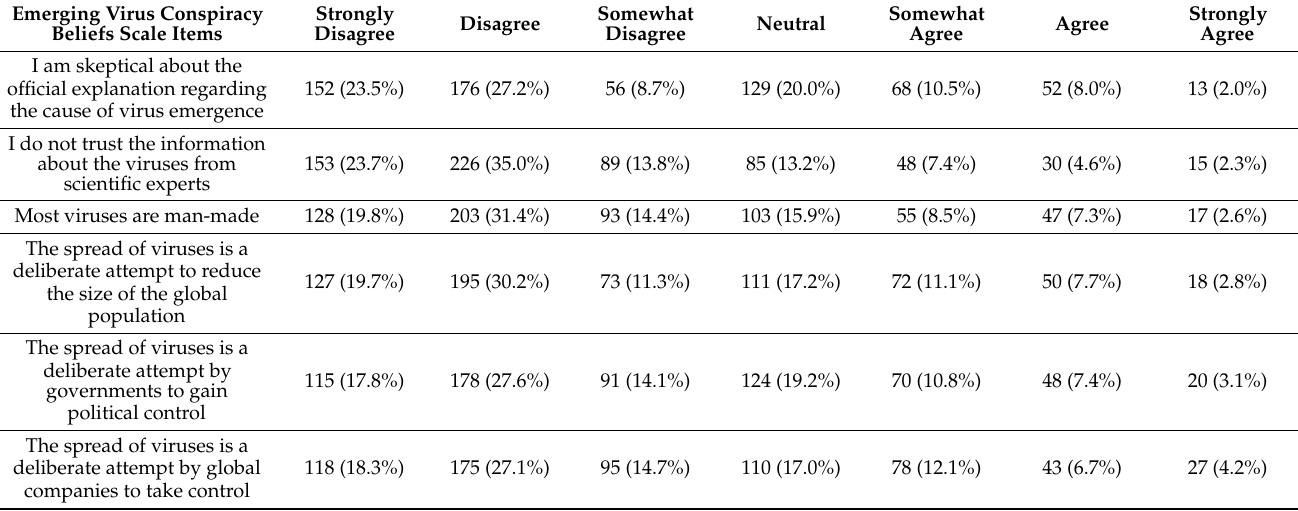
Table 3. Description of the emerging virus conspiracy beliefs scale items’